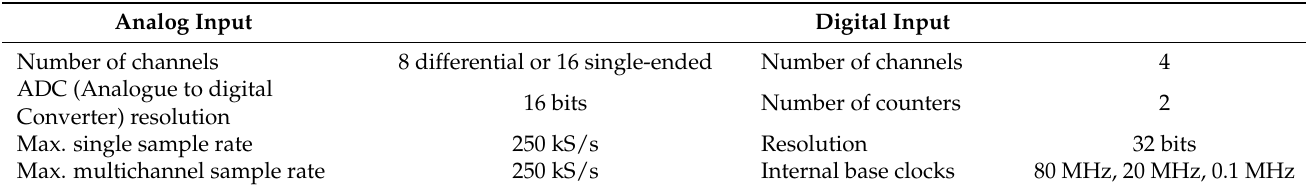
Table 1. DAQ NI USB-6211 SPECIFICATIONS.